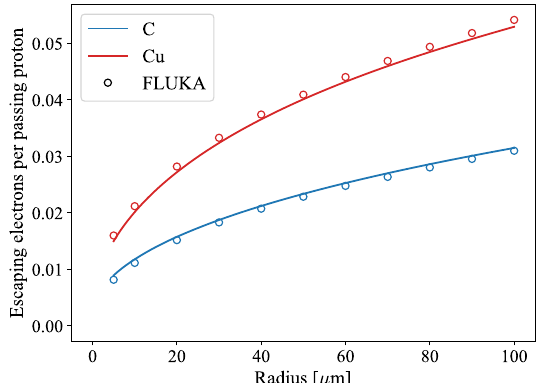
keV.FIG. 4. Average number of escaping electrons per passing proton for a neutral UFO. The updated model (solid lines) is compared to FLUKA (circles).